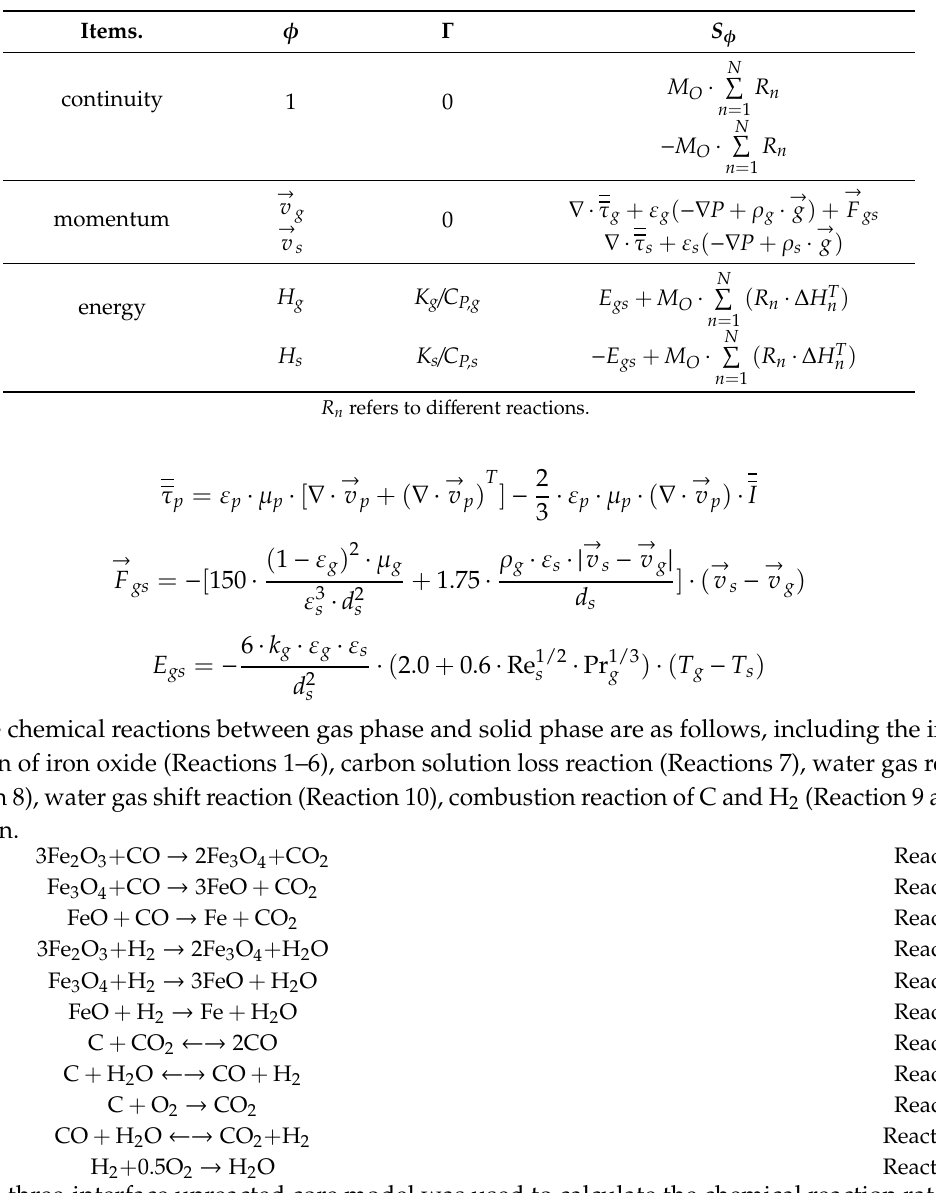
Table 1. Parameters in Equation